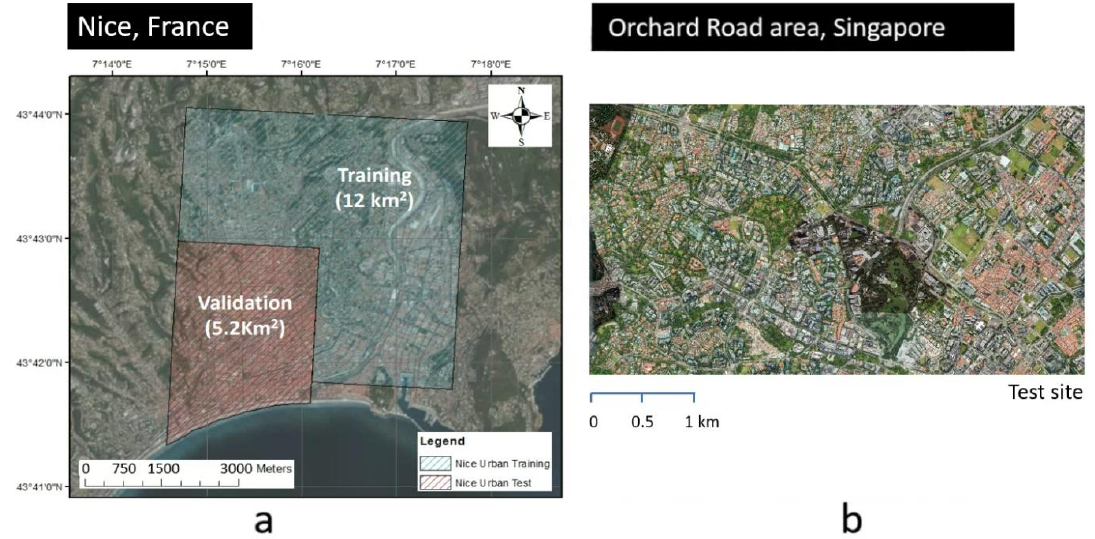
Figure 3. The images of datasets that were used for: ( a ) training and validation sites, ( b ) testing